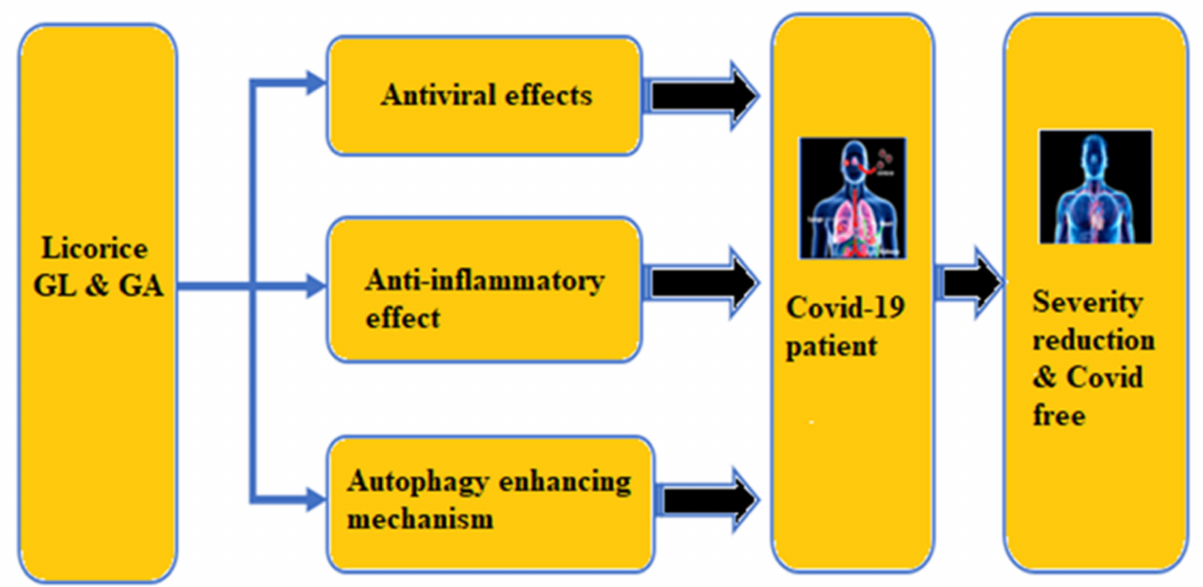
Figure 5. A conceptual diagram showing the effects of licorice on COVID-19